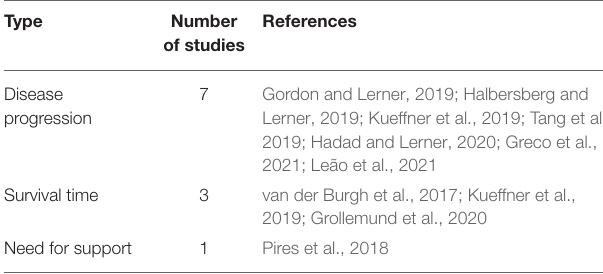
TABLE 5 | Types of prediction addressed by the